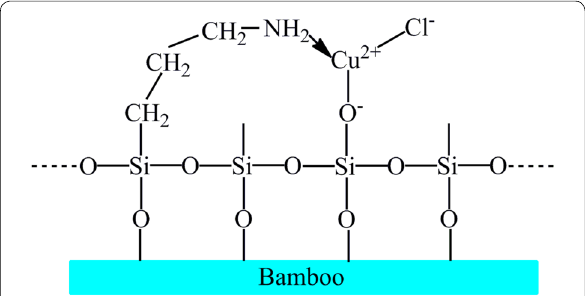
Fig. 8 Schematic of the grafting of copper to the functionalized silica gel in the